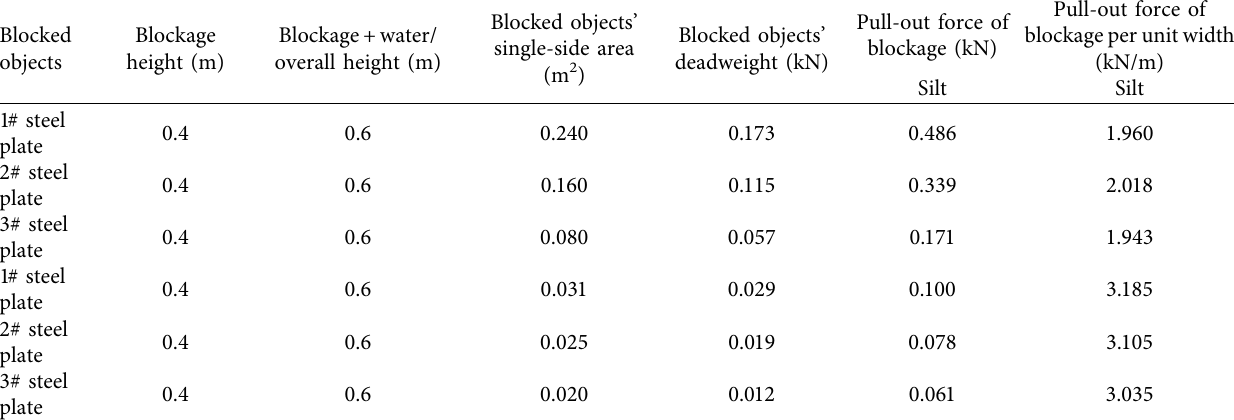
Table 9: Analysis of the influence of plate width on the pull-out force of underwater (single) sediments.